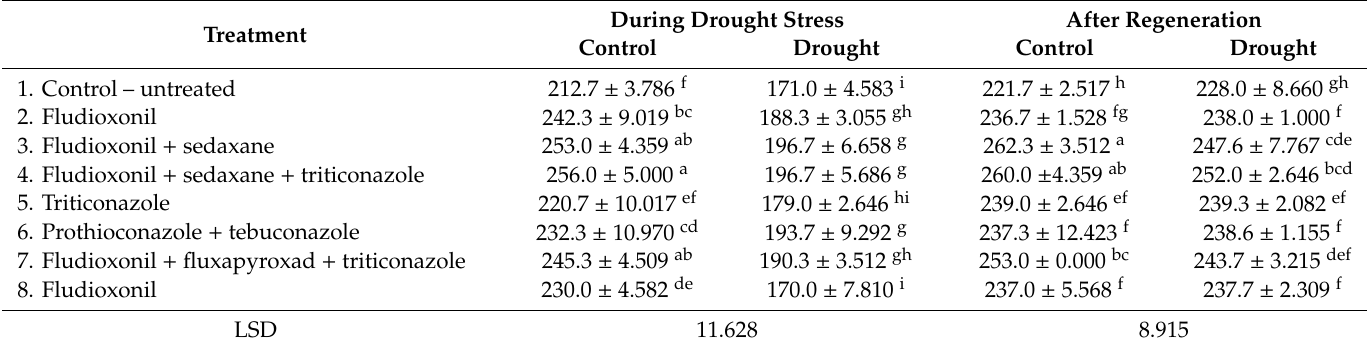
Table 6. The influence of the seed treatment and drought stress on sub-stomatal CO 2 —Ci ( µ mol × mol − 1 ) during drought stress and after